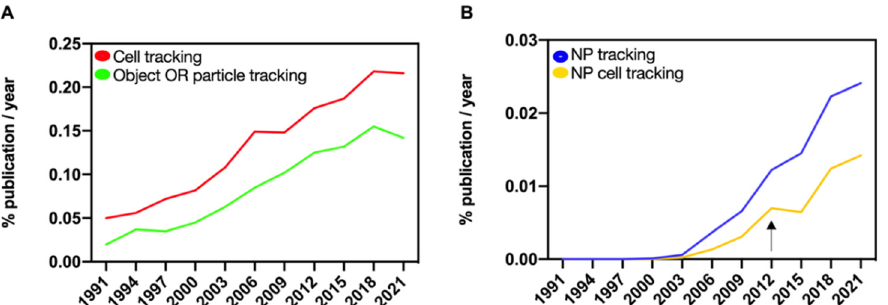
Figure 1. Scientific community interest in tracking related research. Percentage of publications in Web of Science (WoS) database as function of publication year for the indicated combinations of keywords with the field tag «Topic». “OR” was used as Boolean operator to combine the keywords “object” and “particle tracking” and to lunch the search in WoS database. The plot shows the exponentially increasing interest in cell, particle, or object tracking ( A ) as well as tracking with nano systems ( B ) in the biomedical and related literature. The impact of the intrinsic growth of the number of publications was weighed and corrected by plotting percentages.